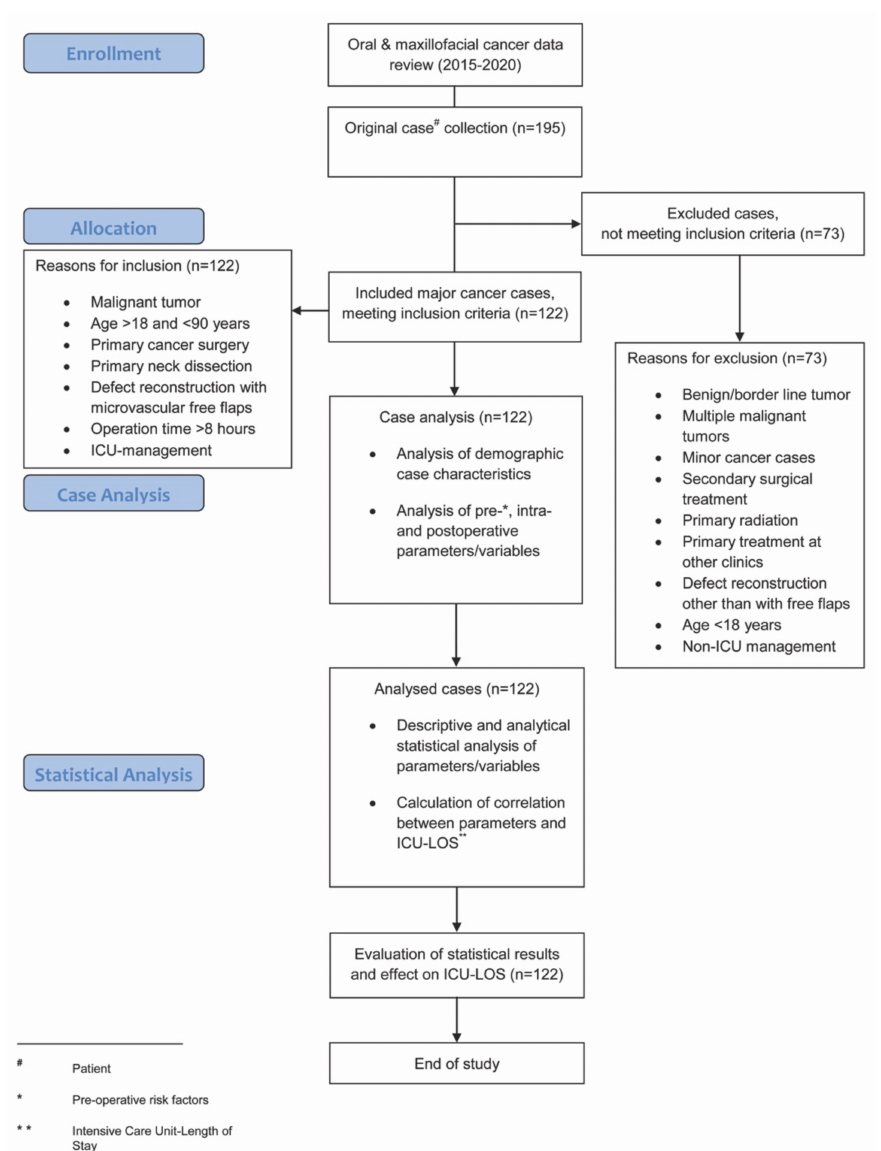
Figure 1. Flowchart diagram demonstrating the steps of the study